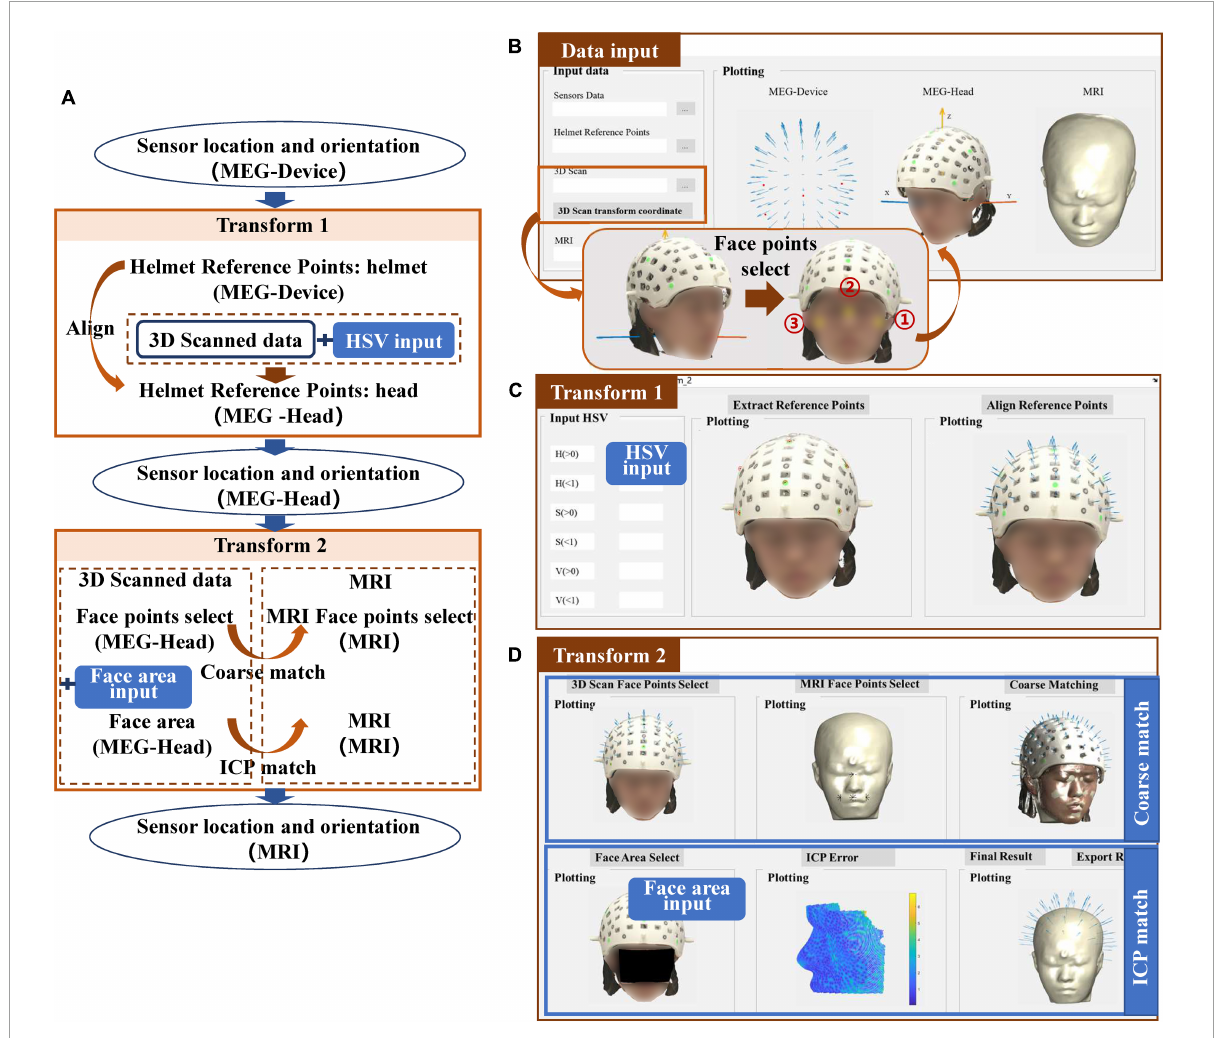
FIGURE3 (A) Workflow of the co-registration of OPM-MEG and MRI for structured-light scanner; (B) interface for importing data; (C) interface for transform 1; (D) interface for transform 2.